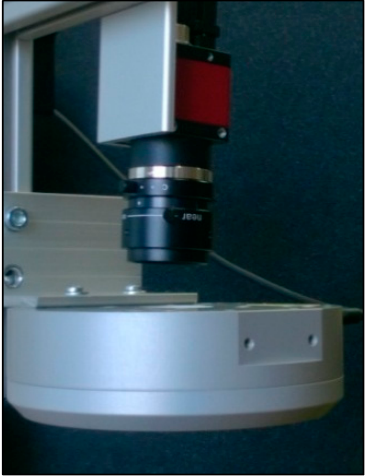
Figure 11. Configuration of the camera and lighting.